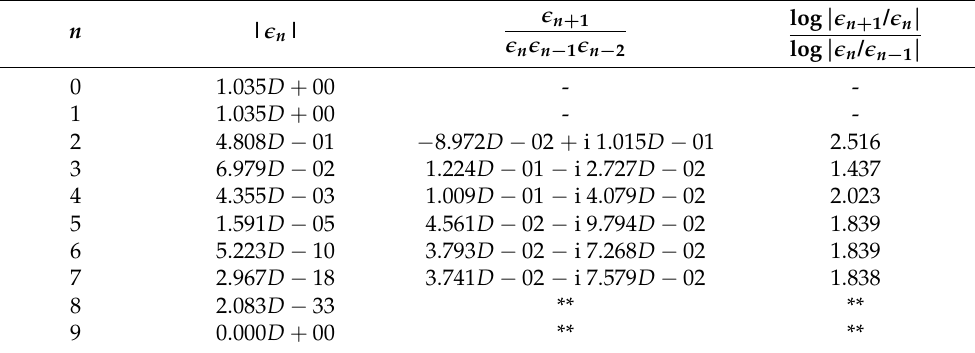
Table 1. Results obtained by applying the generalized secant method with k = 2, as shown in (34) and (35), to the equation z 3 − 8 = 0, to compute the root α 1 = − 1 + i mean that the limit of the extended-precision arithmetic has been reached. n | (cid:101) n |